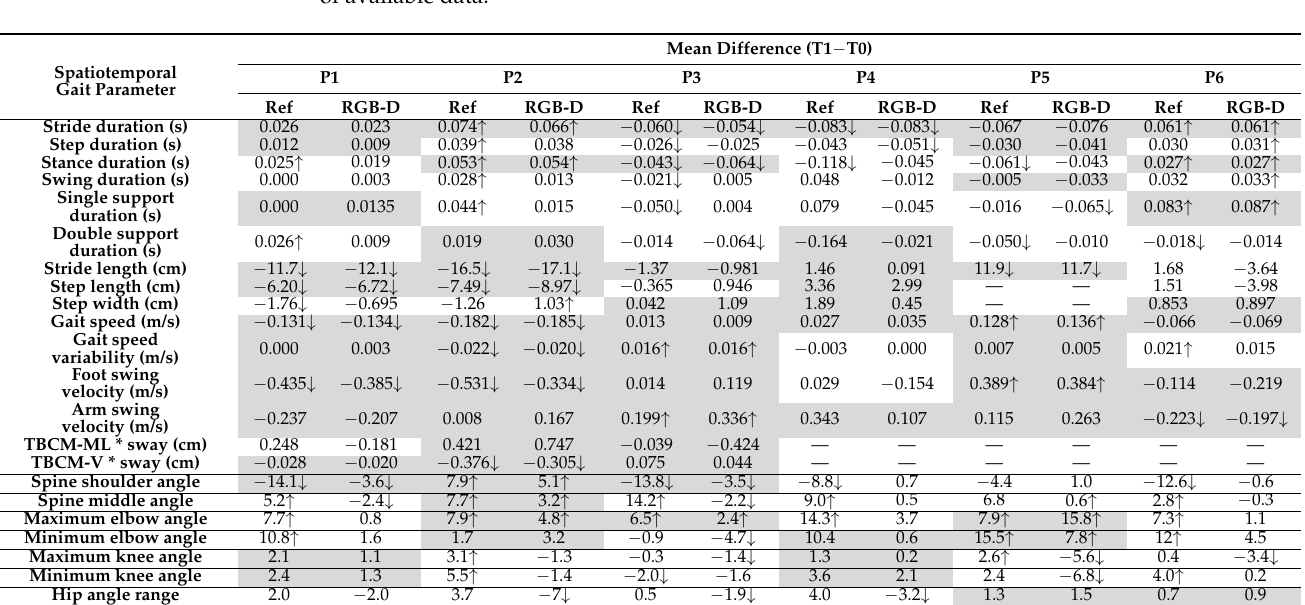
Table 3. Difference between the mean value at T1 and T0, for each parameter, patient, and system (“Ref” stands for reference system and “RGB-D” for RGB-D camera-based system). If a statistically significant difference was found between the parameter’s values at T0 and T1 (Mann–Whitney U Test, p -value ≤ 0.001), the mean difference value is indicated with “ ↑ ” or “ ↓ ” (positive or negative difference, respectively). When there is no significant difference, or when there is a significant difference and the trend is the same (positive or negative), for both systems, the results are highlighted in grey. “—” indicates that it was not possible to perform the statistical test due to the small amount of available